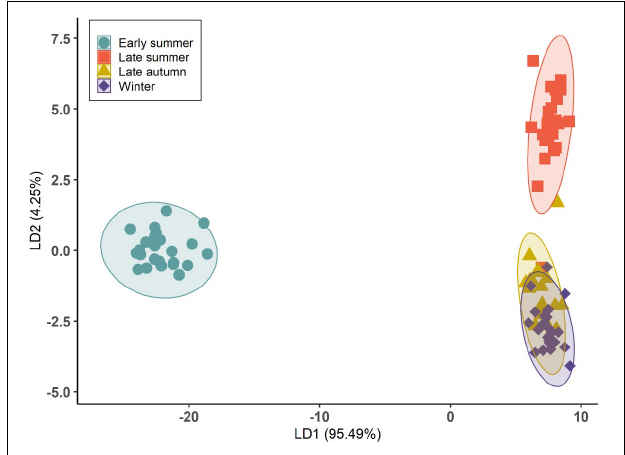
FIGURE 3 | Linear discriminant analysis (LDA) based on the volatile compounds identified from D. subulatum on four different sampling occasions. Ellipse displaying 99% confidence interval ( n =